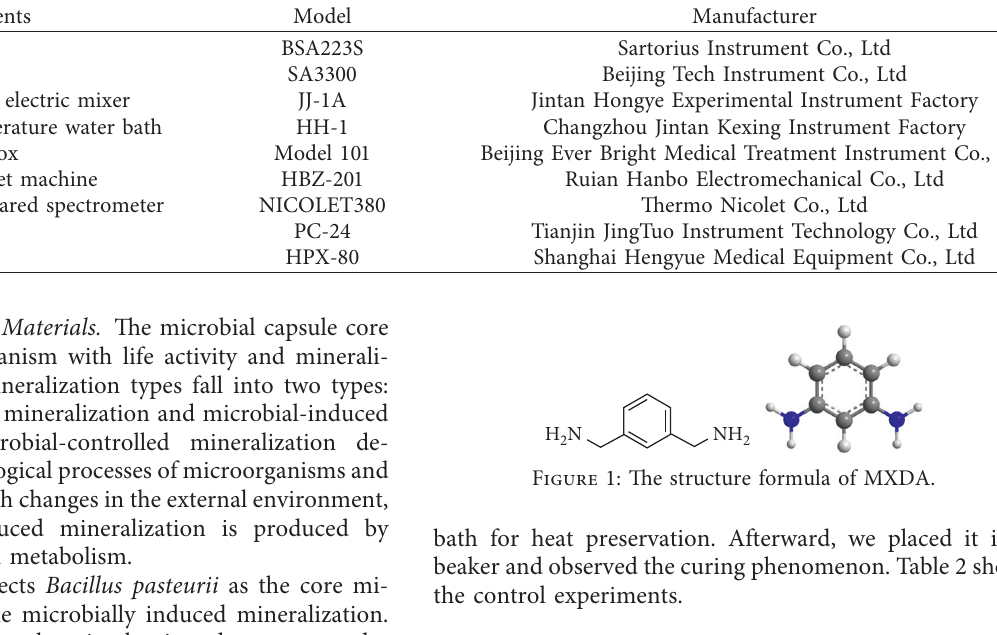
microcrystalline cellulose and hydroxypropyl